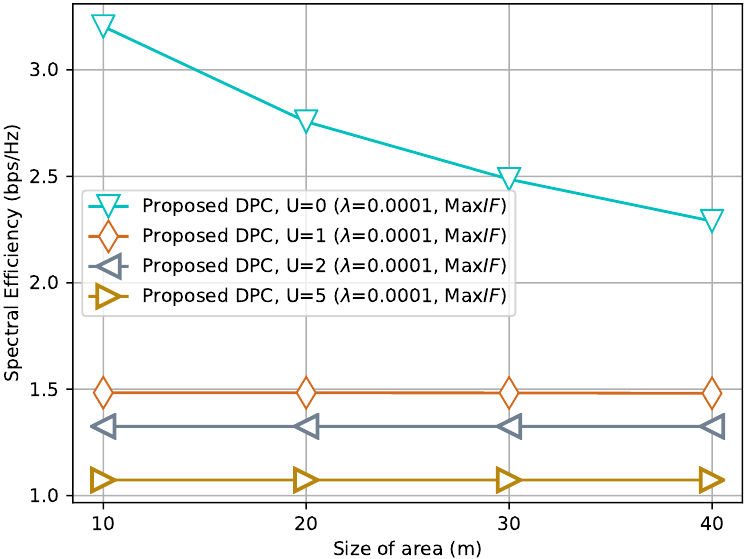
Figure 13. Average spectral efficiency of the proposed scheme for α = 5 in Rayleigh fading channels when the cellular users are in the device-to-device (D2D) communication area.